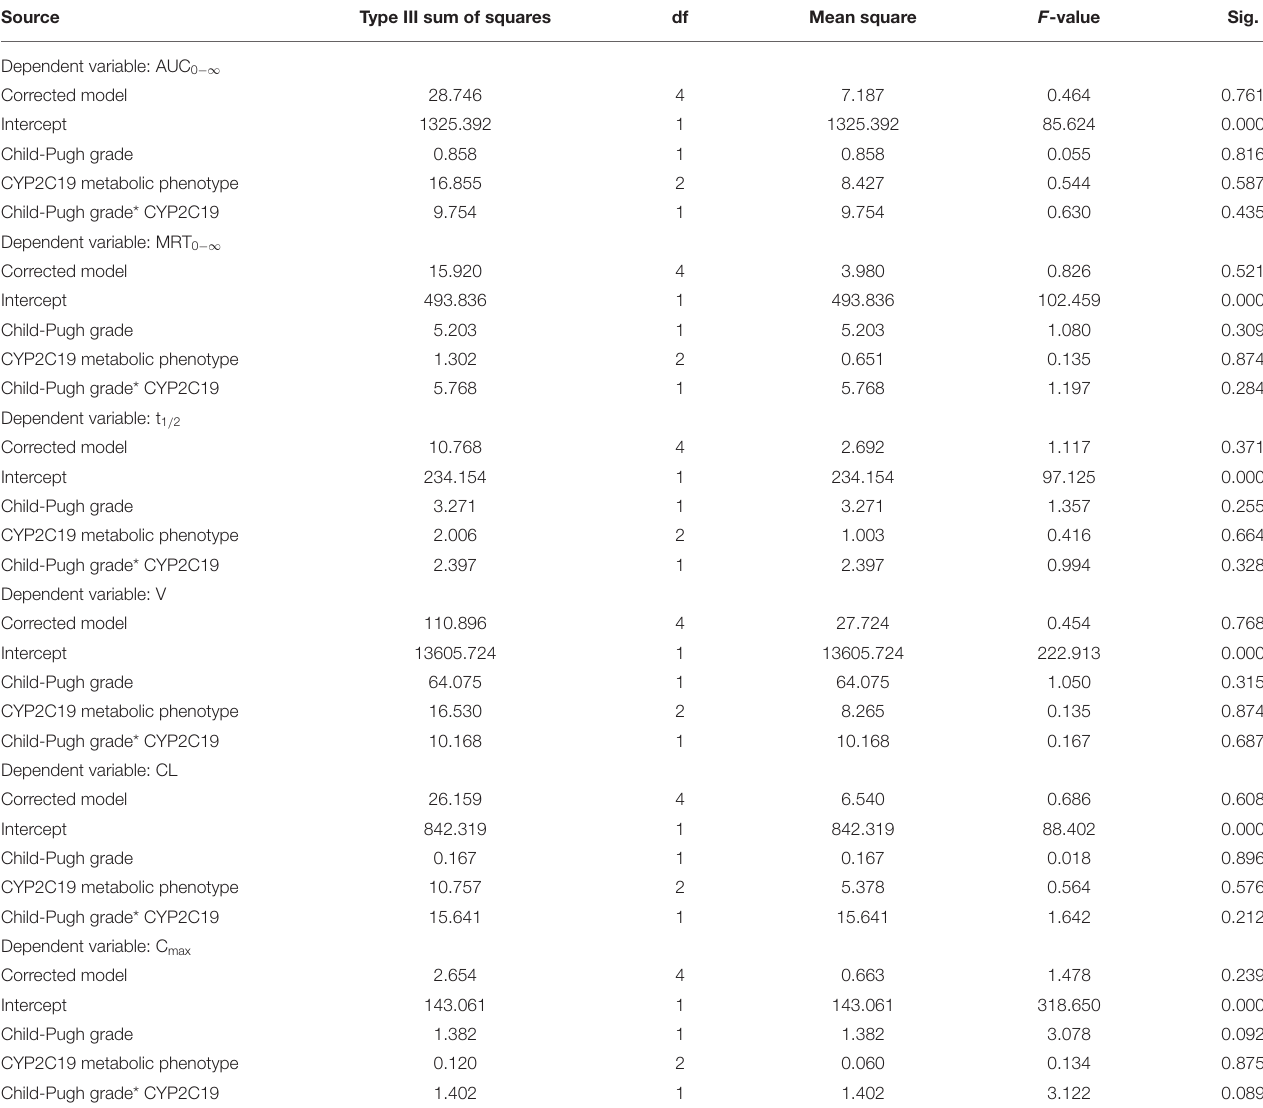
TABLE 6 | Tests of between Child-Pugh grade and CYP2C19 metabolic phenotype